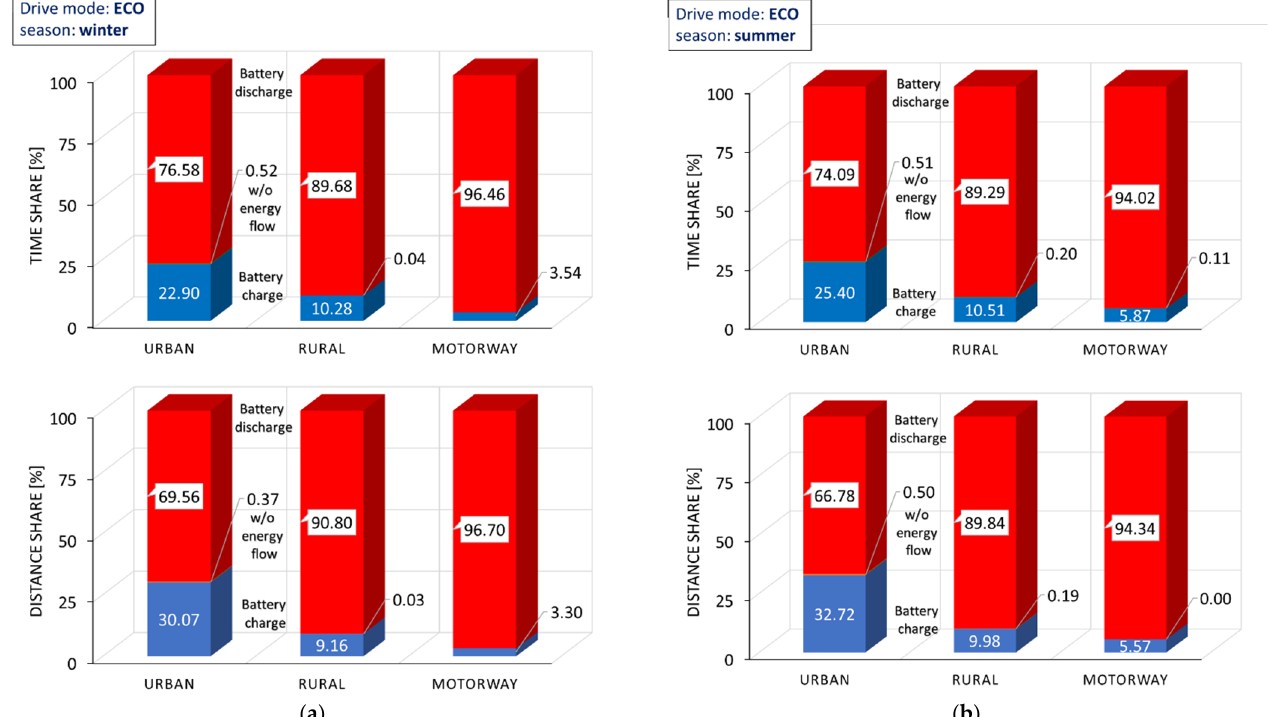
Figure 22. Conditions for the use of the battery energy for: ( a ) winter conditions, ( b ) summer conditions.